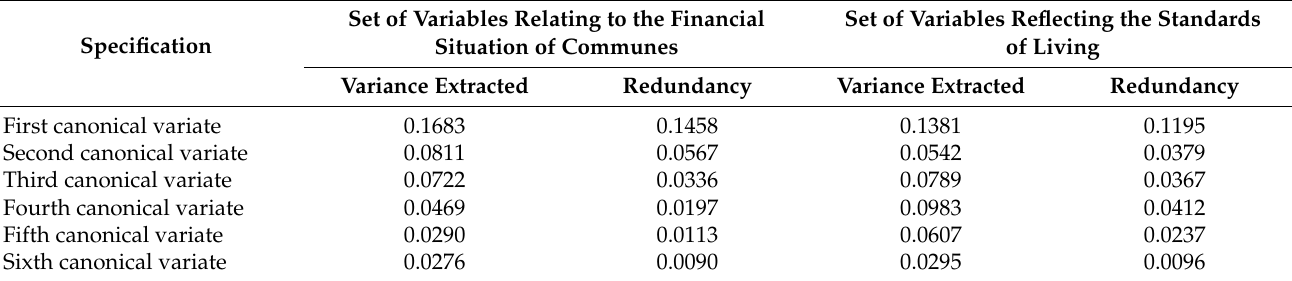
Table 8. Variances extracted and